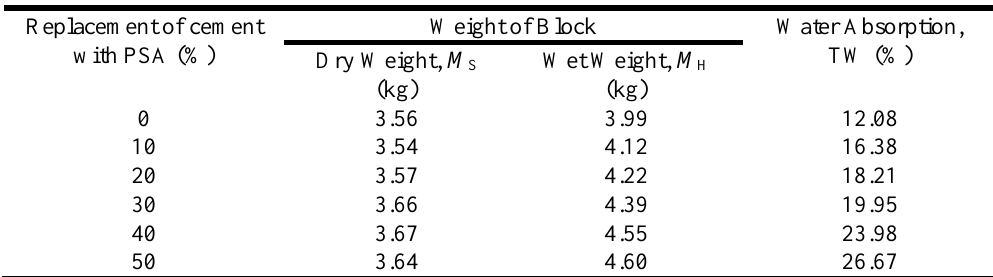
Table 8. Water Absorption of Lateritic Block (developed by the authors, based on the conducted survey) Replacement of cement